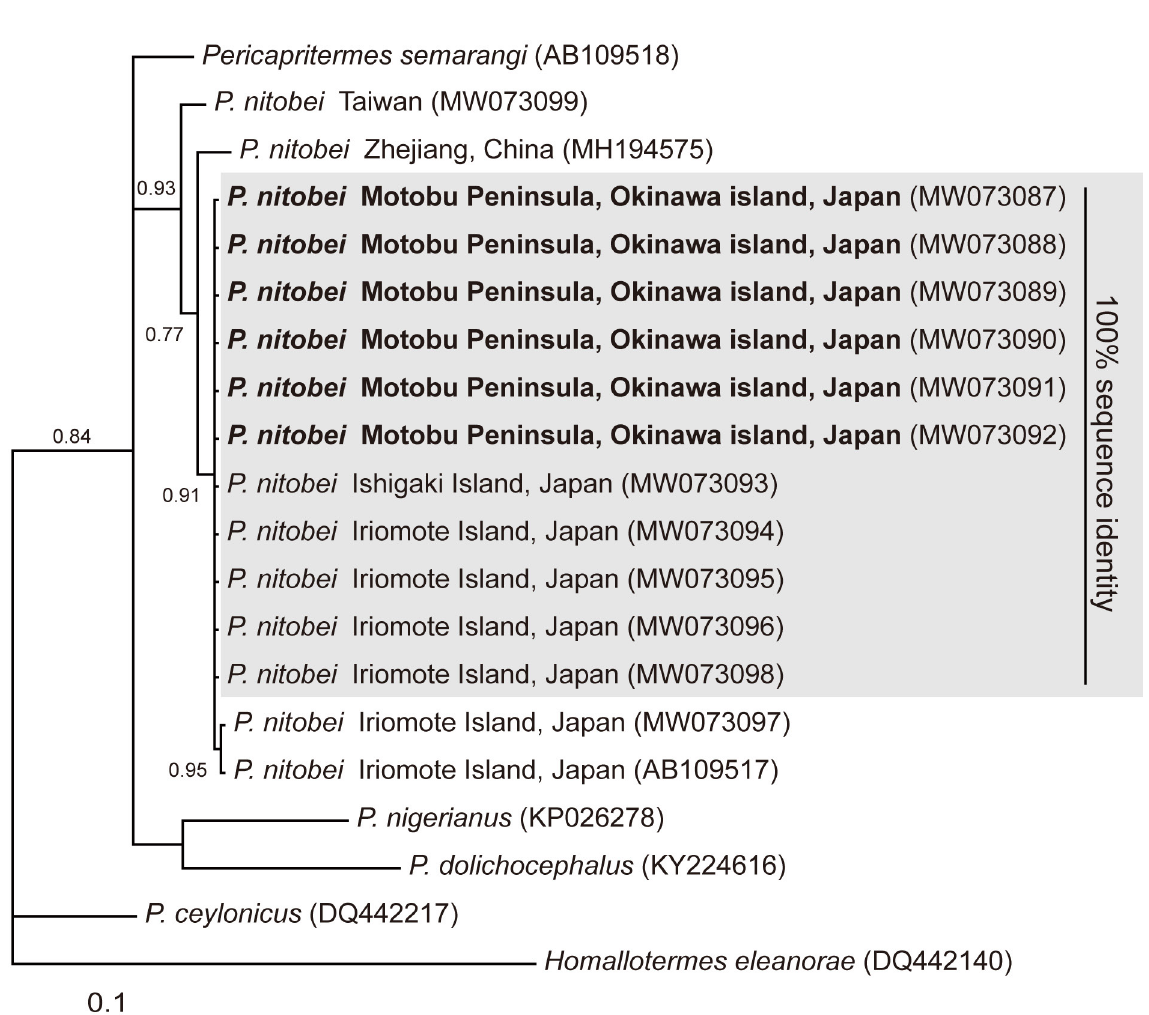
Fig 2. Bayesian phylogenetic tree of Pericapritermes termites based on mitochondrial COII sequences, including the soil feeding termite in the Motobu Peninsula, which was identified as P. nitobei (presented in bold). The corresponding posterior probabilities (≥ 0.70) are shown by the branches. GenBank accession numbers are shown in